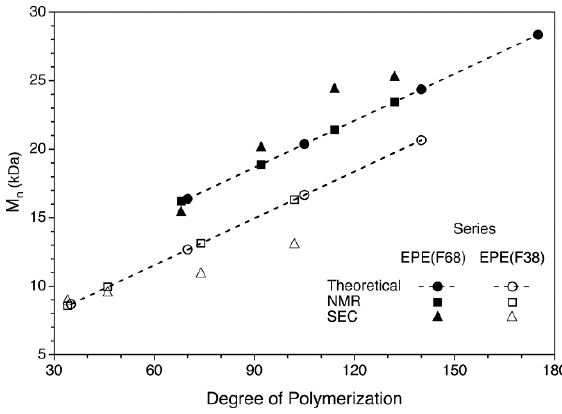
Figure 4. Dependence of 𝑀(cid:3365) (cid:3041)